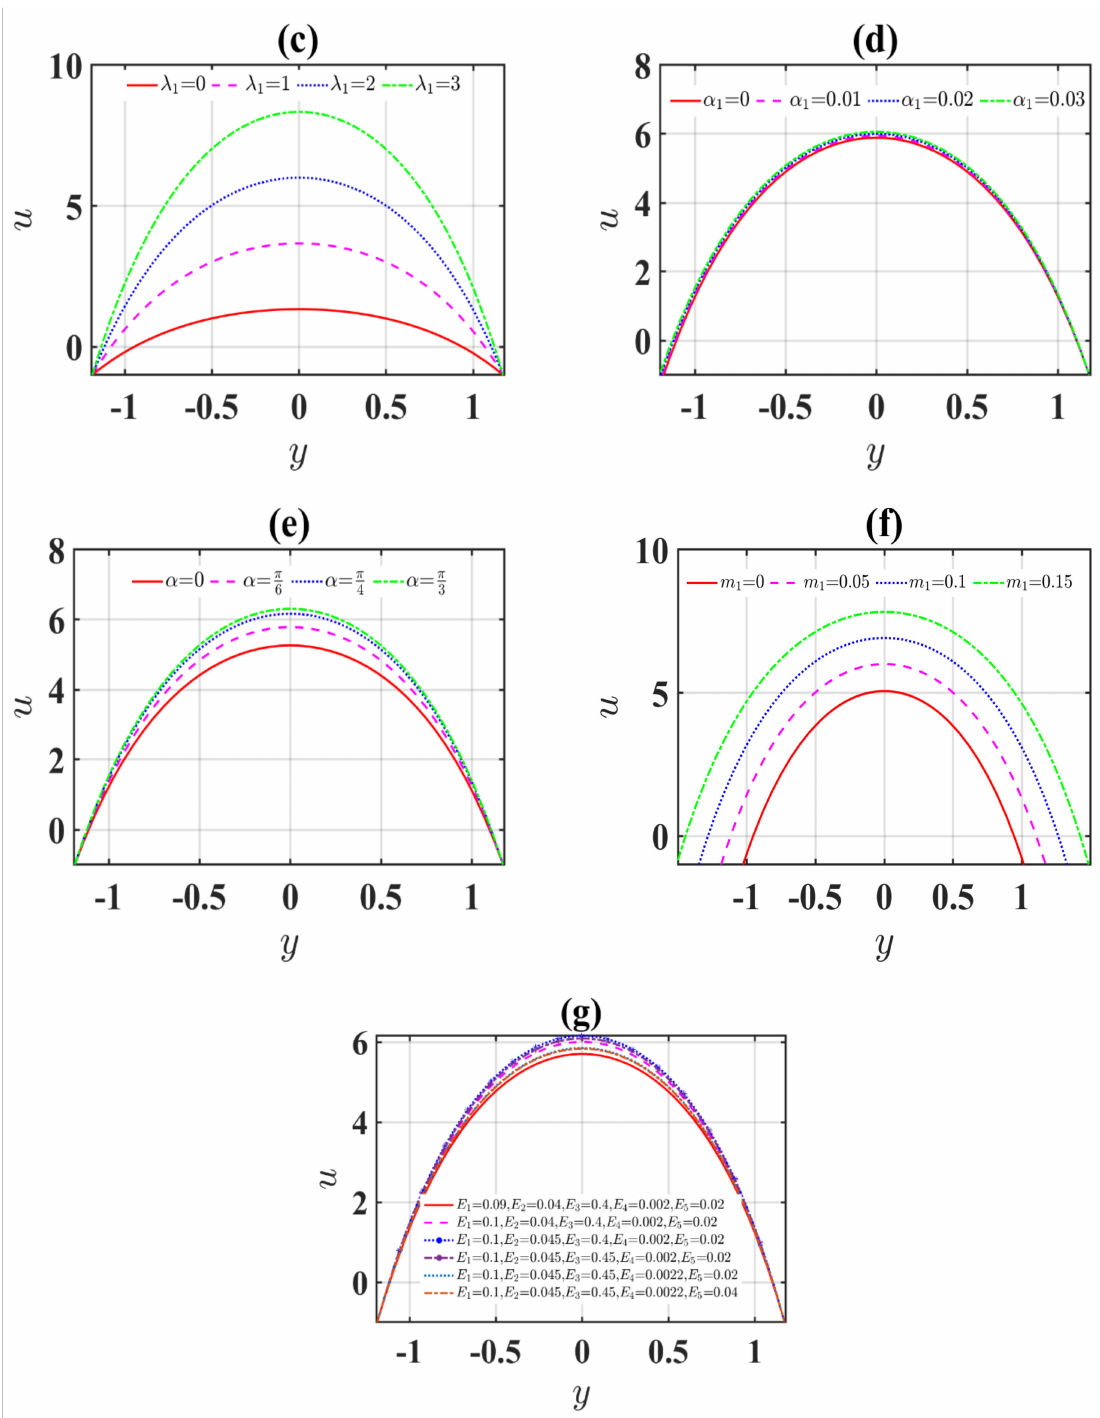
Figure 2. Velocity profiles for varying ( a ) U hs , ( b ) m e , ( c ) λ 1 , ( d ) α 1 , ( e ) α , ( f ) m 1 , and ( g ) E 1 − E 5